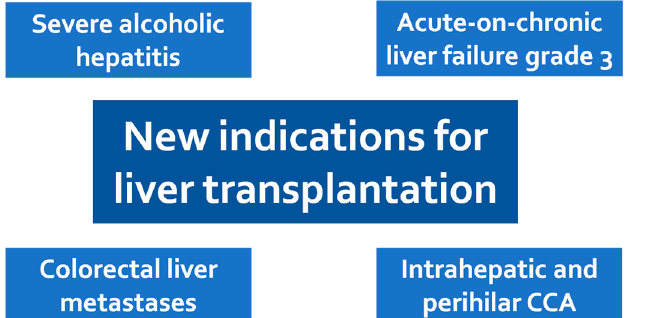
Figure 1. New indications for liver transplantation. Controversial indications include severe alcoholic hepatitis and ACLF grade 3. Questionable indications include non-hepatocellular carcinoma liver cancer, and liver metastases from colorectal cancer. CCA: cholangiocarcinoma; ACLF: acute-on-chronic liver failure.